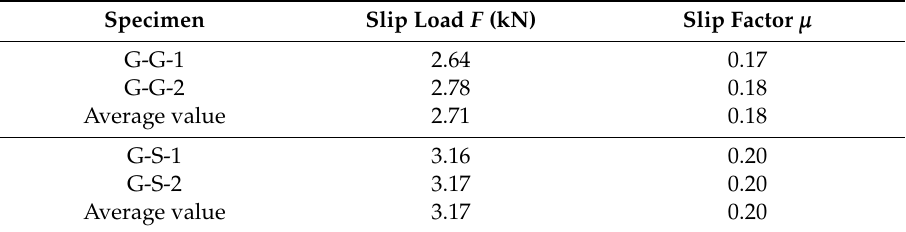
Table 7. The slip load and slip factor values of tested connections with di ff erent cover